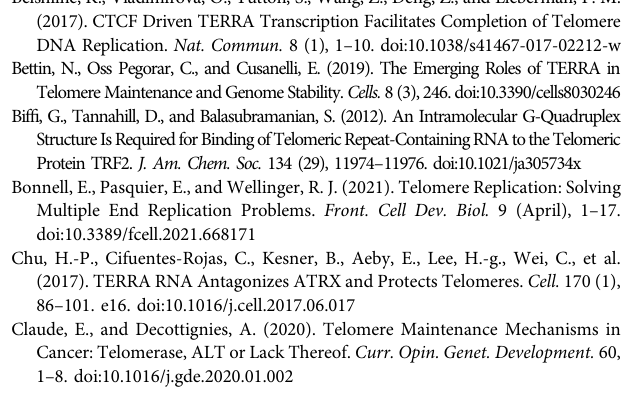
Supplementary Figure S1 | TERRA anomalous diffusion exponents and effective diffusion coef fi cients. (A) MSDs for non-telomeric and telomeric TERRA foci at timescale 0 – 1 s. (B) MSDs for non-telomeric and telomeric TERRA foci at timescale 10 – 100 s. (C) Average diffusion coef fi cients of non-telomeric and telomeric foci at timescale 0 – 1 s and 10 – 100 s. *** indicates p < 0.001. N.S., not signi fi